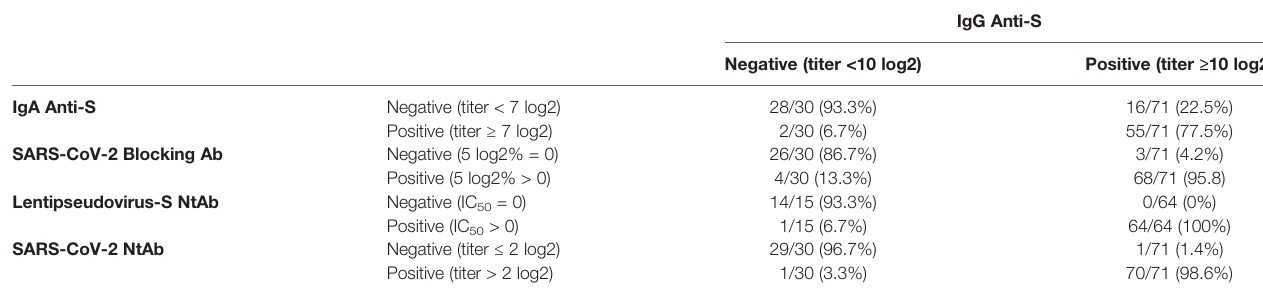
TABLE 4 | Percent agreement of positivity and negativity of IgA binding and functional antibodies to IgG anti-S binding antibody.